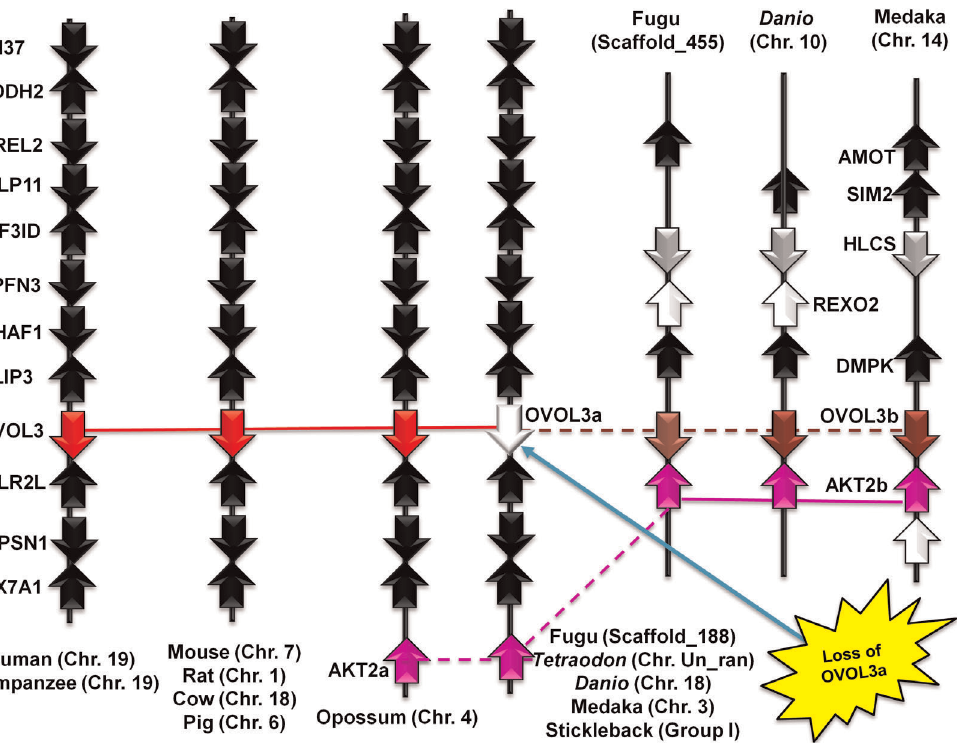
Figure 5. Synteny analysis of OVOL3 genes illustrates the loss of OVOL3a after duplication event and maintenance of paralogous OVOL3b in fishes. LIN37: lin-37 homolog ( C. elegans ); PRODH2: proline dehydrogenase (oxidase) 2; KIRREL2: kin of IRRE like 2 ( Drosophila ); APLP1: amyloid beta (A4) precursor-like protein 1; NFKBID: nuclear factor of kappa light polypeptide gene enhancer in B-cells inhibitor, delta; LRFN3: leucine rich repeat and fibronectin type III domain containing 3; SDHAF1: succinate dehydrogenase complex assembly factor 1; CLIP3: CAP-GLY domain containing linker protein 3; POLR2I: polymerase (RNA) II (DNA directed) polypeptide I, 14.5 kDa; CAPNS1: calpain, small subunit 1; COX7A1: cytochrome c oxidase subunit VIIa polypeptide 1 (muscle); DMPK: dystrophia myotonica-protein kinase; HLCS: holocarboxylase synthetase; AMOT: